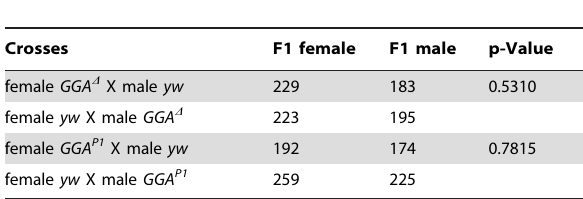
Table 2 Testing semi-lethality of the GGA D and GGA P1 alleles.